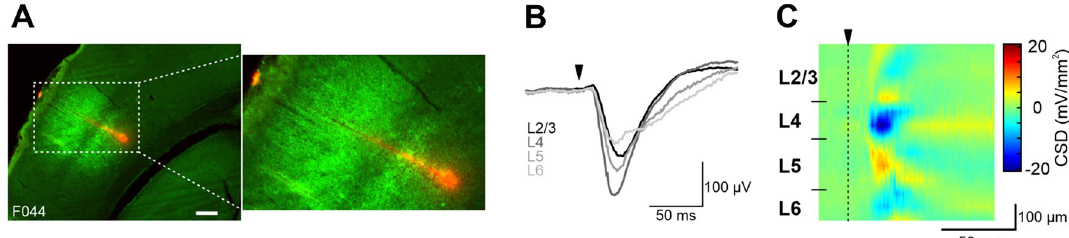
Figure 1. Illustration of the experimental approach and example recording traces. ( A ) Left: Coronal slice of mouse barrel cortex showing opsin expression (green) and probe penetration (DiI, red). Scale bar: 200 µm. Right: Magnification of the enclosed area in the left picture. ( B ) Example LFP traces from one mouse (low-pass filtered at 250 Hz). Shown are selected channels from each cortical layer, averaged over 24 W1 deflections. The triangle indicates stimulus onset. ( C ) Example CSD profile showing allocation of cortical layers to electrode channels (32 channels, 25 µm inter-electrode